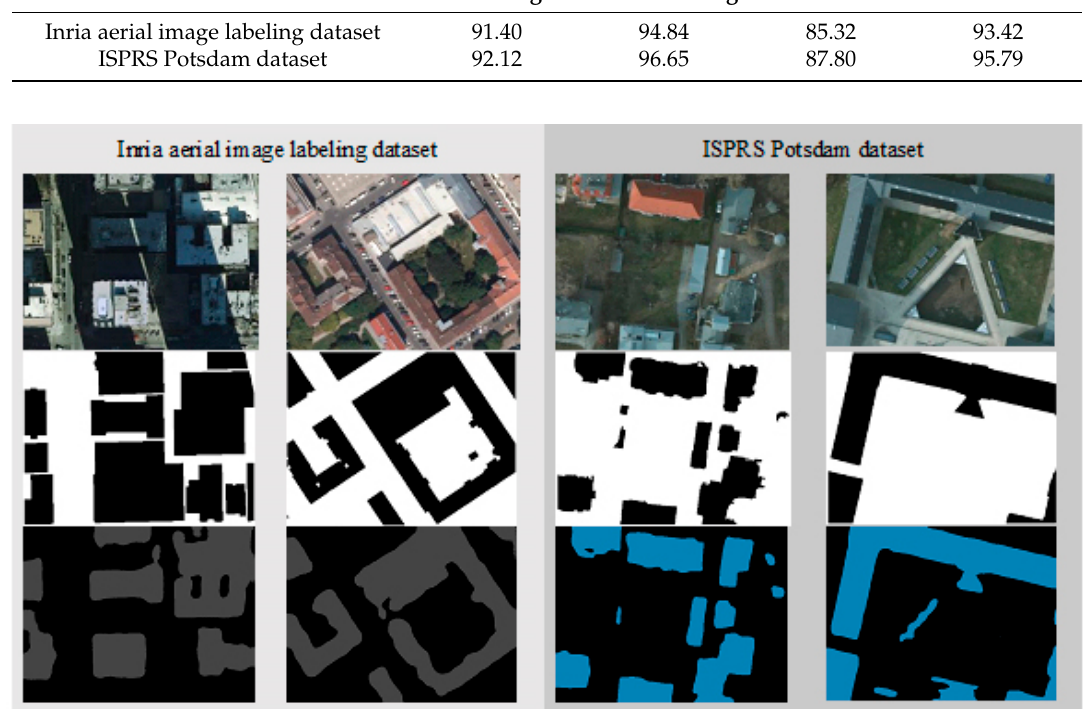
Figure 7. Visual segmentation results on Inria aerial dataset ( left ) and ISPRS Potsdam dataset ( right ) which consist of input color image ( top ), reference segmentation data ( middle ), and building extraction result ( bottom ).